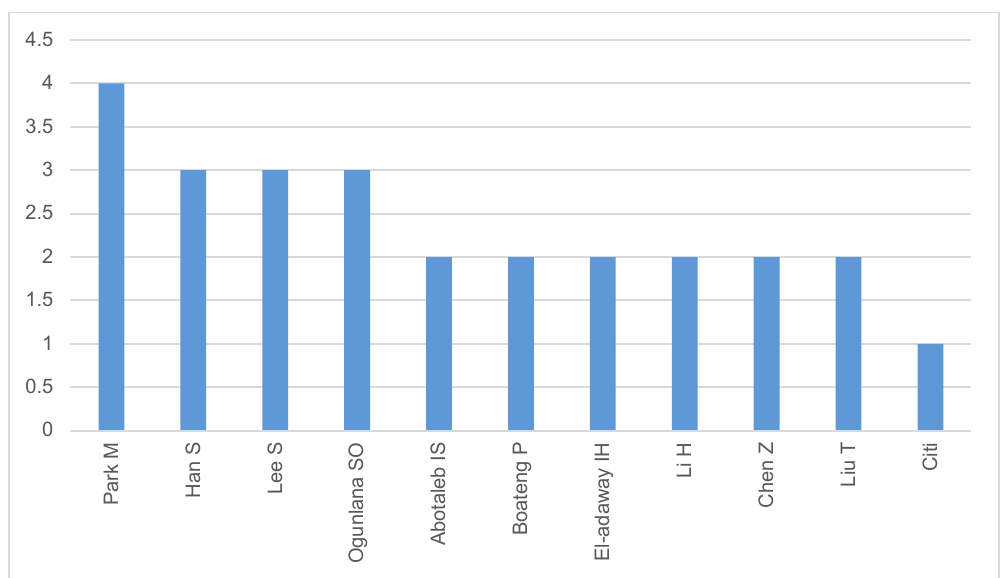
Fig. 5. Distribution of the number of articles by year. Source: created by the author based on data from Clarivate analytics